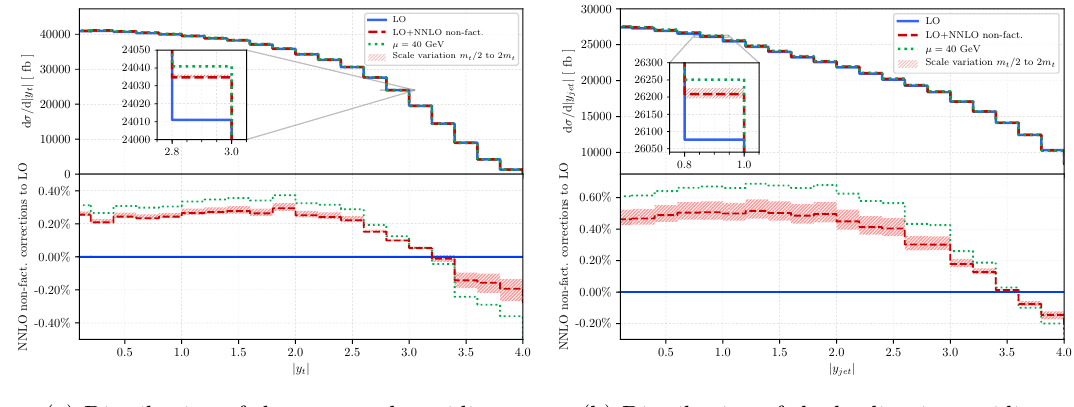
Figure 4. Distributions of the absolute value of the top-quark rapidity (left) and of the leading- jet rapidity (right). LO distributions are marked with a blue, solid line, while red, dashed lines correspond to our predictions for LO+NNLO distributions at µ = m t . The scale is variated between µ = m t / 2 and µ = 2 m t . The green, dotted line corresponds to the scale µ = 40 GeV. Lower panes show the ratio of non-factorisable corrections to LO distributions. See text for further